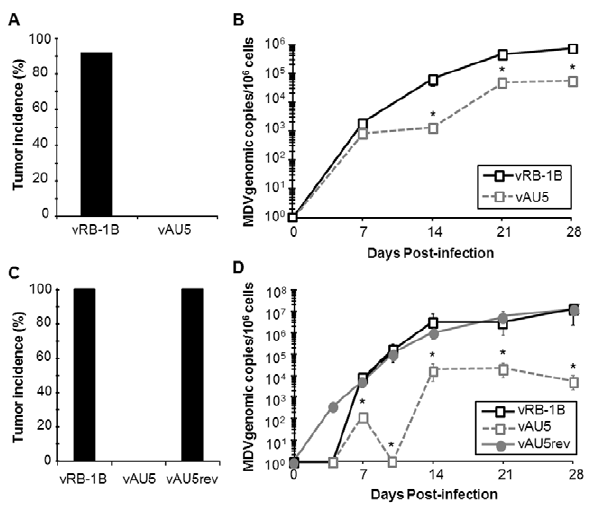
Figure 4. Tumor induction and in vivo replication of MDV harboring mutant template sequence (AU5) vTR. MD-susceptible chickens were inoculated with 1,000 PFU of either vRB-1B (n=12) or vAU5 (n=11) in experiment 1 (A and B) and 2,000 PFU of vRB-1B